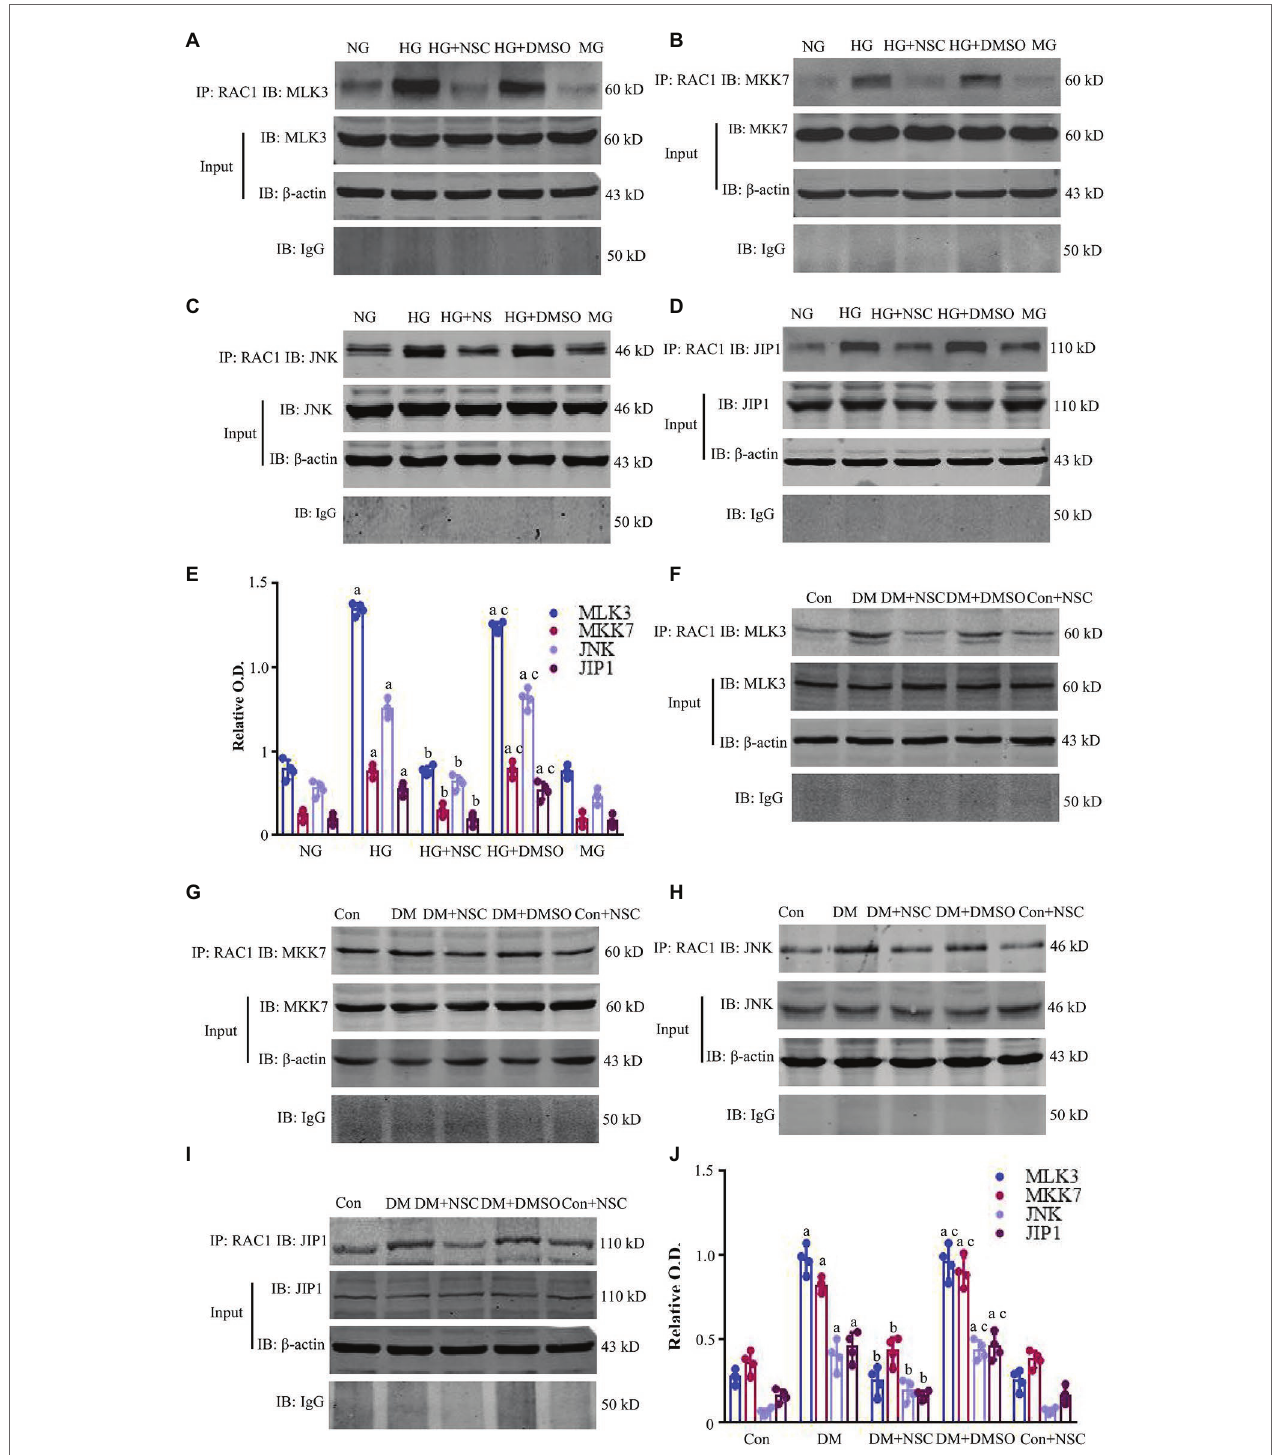
FIGURE 5 | Co-immunoprecipitation (Co-IP) of RAC1 and the mixed lineage kinase 3- mitogen-activated protein kinase 7- c-Jun N-terminal kinase (MLK3-MKK7- JNK) signaling module. (A–D) Co-IP showing the interactions between RAC1 and MLK3, MKK7, JNK, and JNK-interacting protein 1 (JIP1) in HEK-293 T cells. (E) Bands in (A–D) calculated by OD analysis. Data are shown as mean ± SD. (F–I) Representative WB bands displaying the co-IP of RAC1 and the MLK3-MKK7- JNK signaling module in the renal cortex. (J) The intensity of proteins (F–I) is represented as mean ± SD. a p < 0.05 vs. the NG group (E) and the Con group (J) ; b p < 0.05 vs. the HG group (E) and the DM group (J) ; c p < 0.05 vs. the HG + NSC (E) group and the DM + NSC group (J) . n = 4 in each